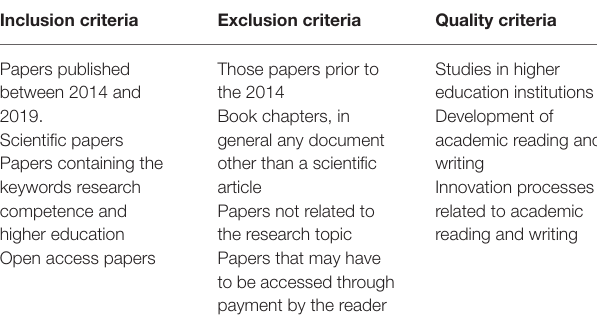
TABLE 3 | Inclusion, exclusion, and quality